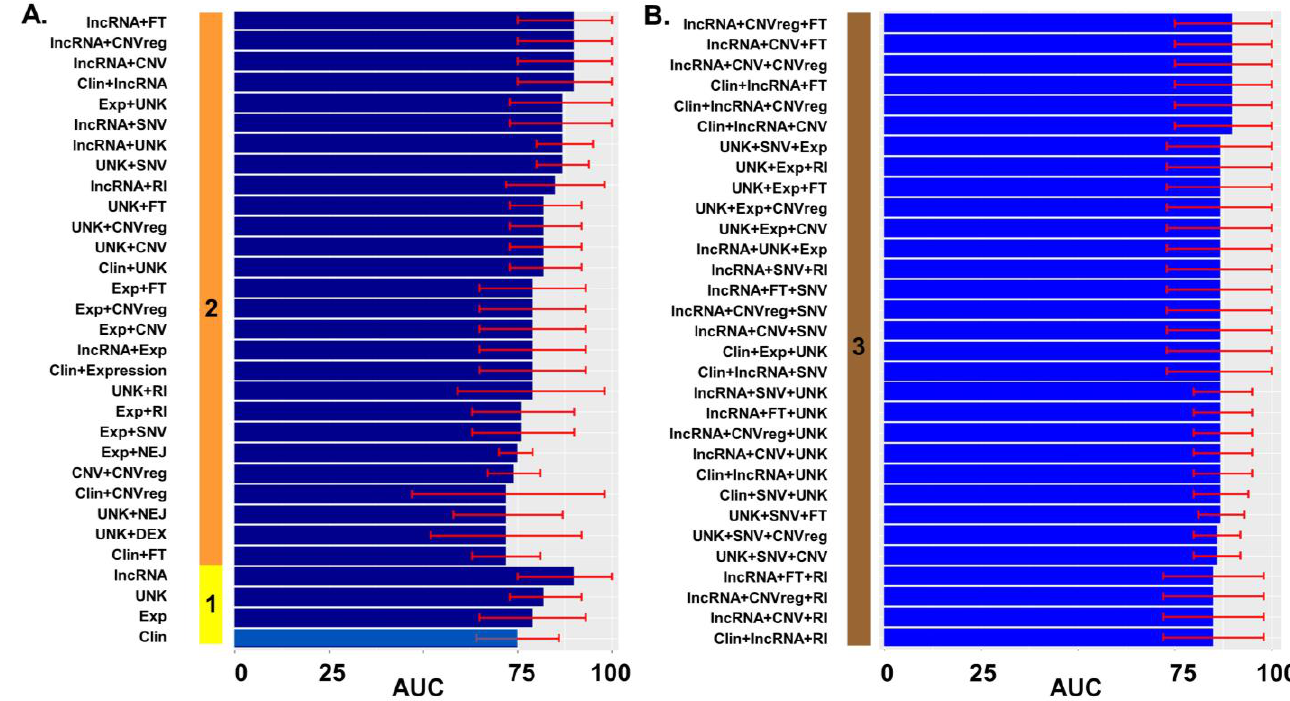
Figure 3. Performance of prediction models of EEC recurrence. ( A ) The solid vertical bar represents the number of types of data: 1 (yellow): only one variable was included in the model; 2 (orange): combination of two types of variables; ( B ) The solid vertical maroon bar represents the combination of three types of variables. Different performances on both panels are displayed in ascending order. The x axis is AUC as a percentage (0 – 100%). The red error mark displays the 95% confidence interval (CI). Overall, 72 models with different combinations of data were tested. We only displayed the best ( A ) 30 models for combinations of one and two variables and ( B ) 30 best models for combinations of three types of variables. Exp: gene expression; DEX: exon expression; lncRNA: long non-coding RNA; SNV: single nucleotide variation; CNV: gene copy number by gene; CNVreg: copy number by chromosomal region; FT: Fusion transcripts; RI: Retained intron; NEJ: Novel exon/junction; UNK: Unknown SV. Graphics were generated with R package ggplot.